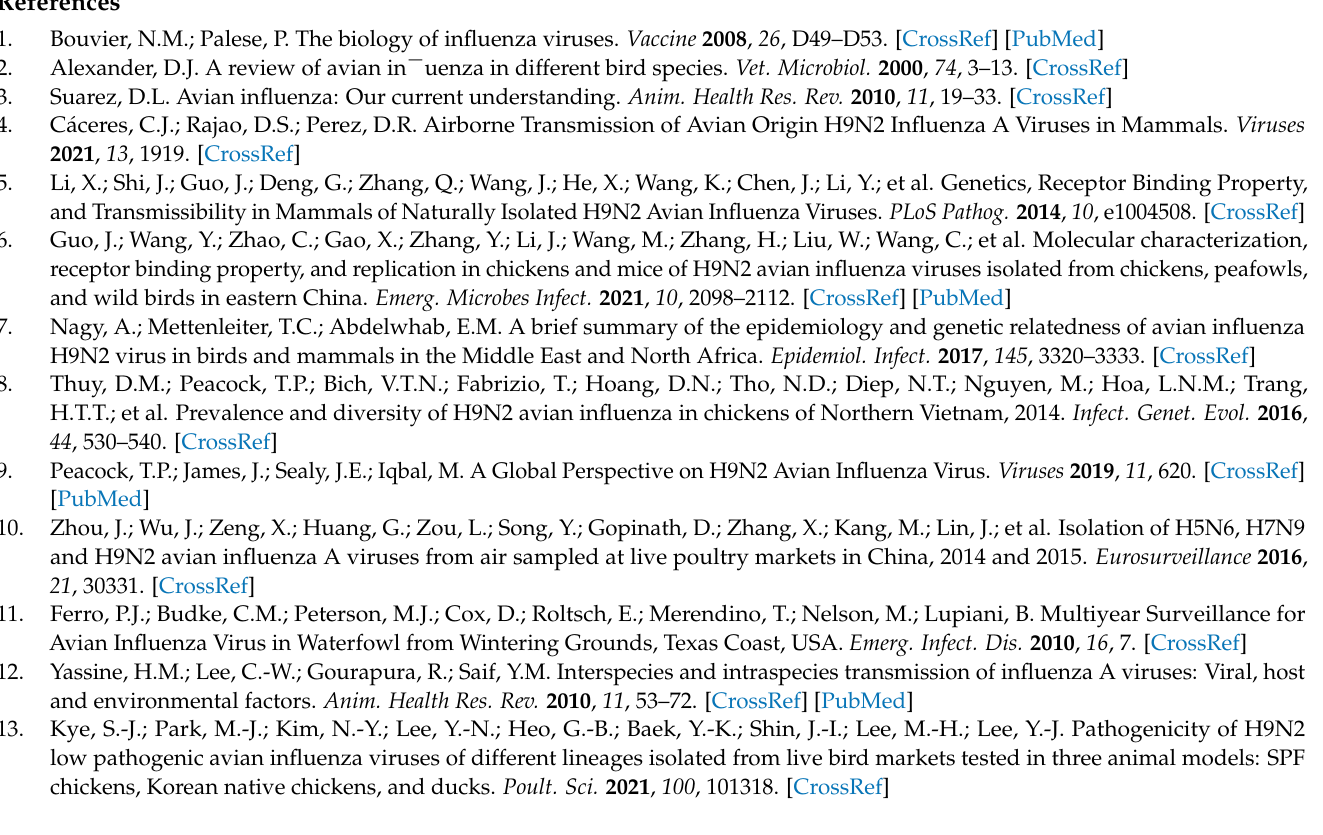
Experimental design for Trial 2, Figure S3: The figure represents the H9N2 AIV shedding (expressed in TCID 50 /mL) in the oral (A–D) and cloacal swabs (D–G) on days 3-, 5-, 7,- and 9 PI in the seeder chickens of trial